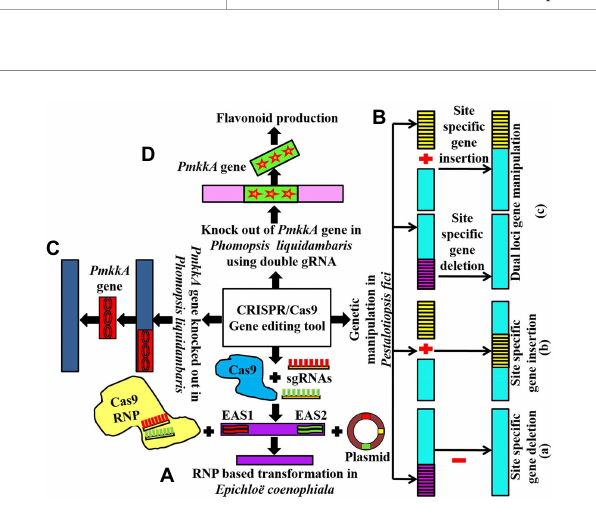
FIGURE 2 (A) Showing RNP-based transformation and disruption of EAS1 and EAS2 gene clusters in Epichloë coenophiala using the CRISPR/Cas9 technique; (Ba,b) communicating CRISPR/Cas9-based single locus gene manipulation in Pestalotiopsis fici; (c) showing dual loci gene editing in Pestalotiopsis fici using CRISPR/Cas9 technology; (C) showing knocking out of PmkkA gene in Phomopsis liquidambaris using CRISPR/Cas9 tool (D) conveys the role of CRISPR/Cas9 to knockout PmkkA gene using double gRNA in Phomopsis liquidambaris resulting in the production of